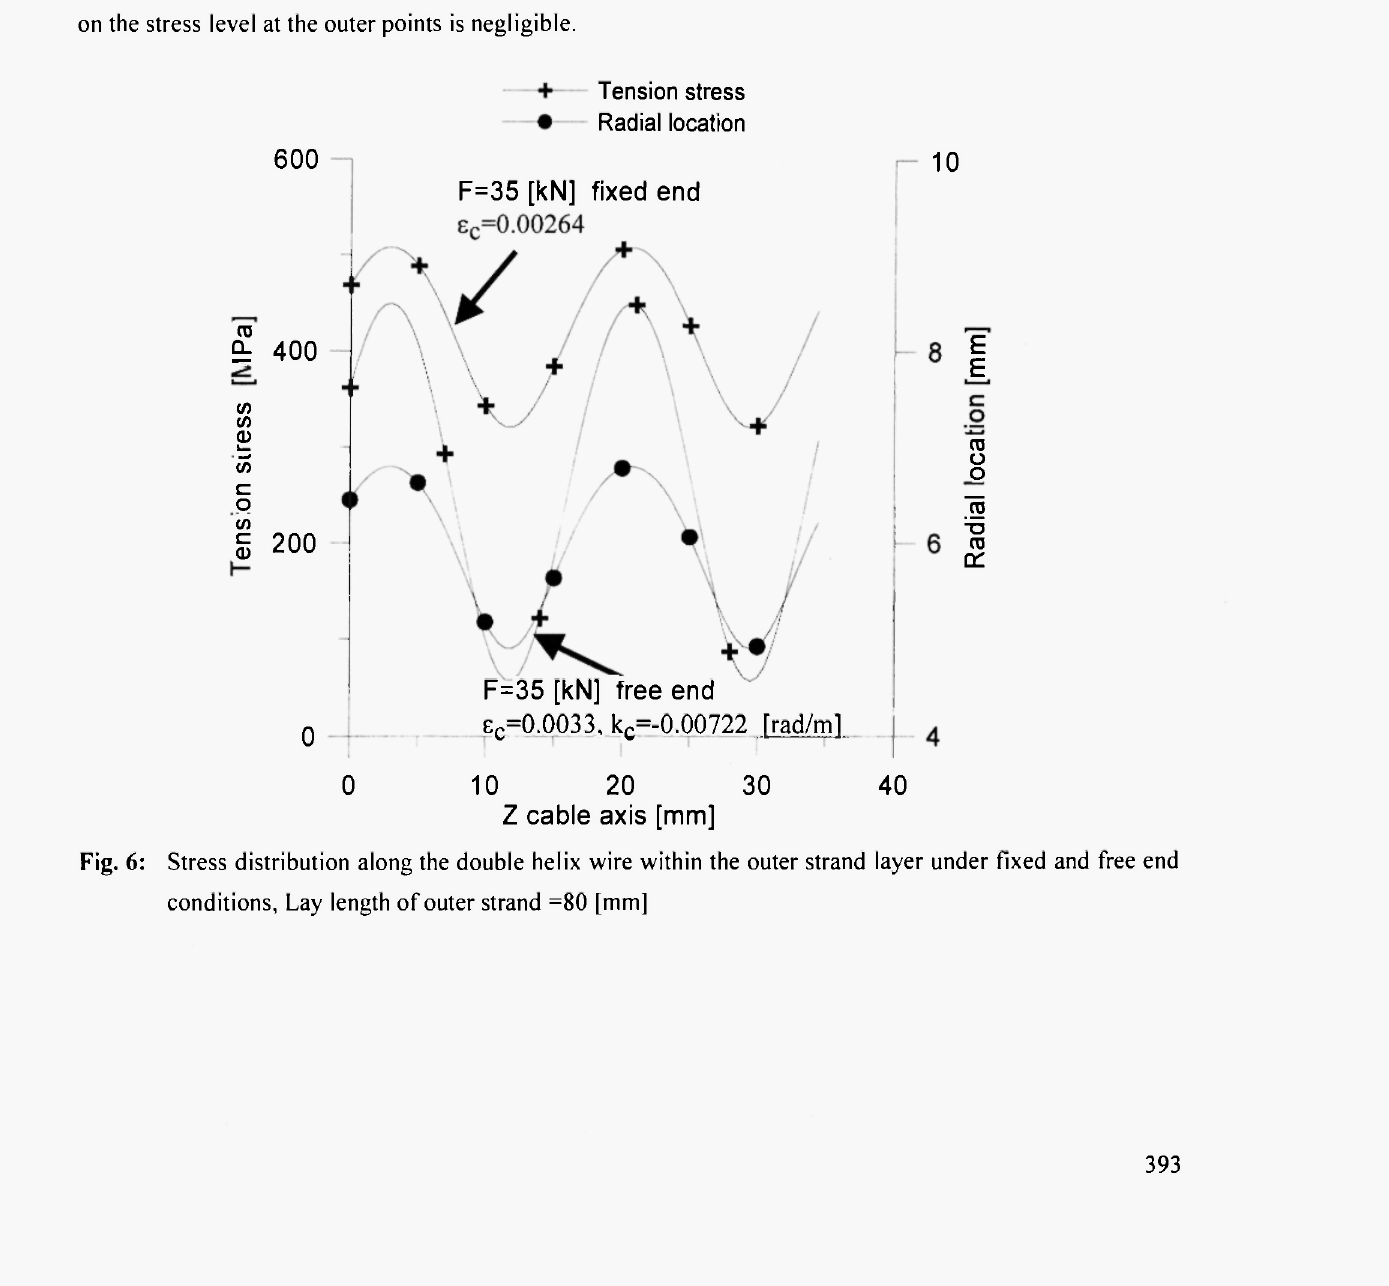
Stress distribution along the double helix wire within the outer strand layer under fixed and free end conditions, Lay length of outer strand =80